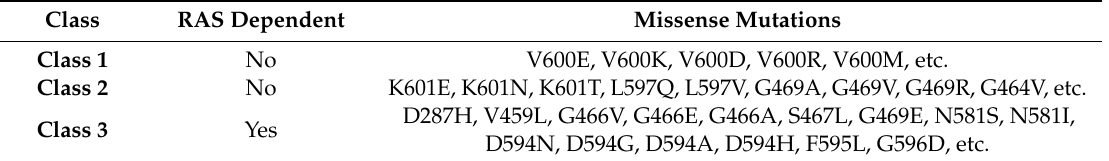
Figure 2. BRAF mutation spectrum in cancer. TCGA pan-cancer studies from cBioportal (https://www.cbioportal.org) were used for BRAF mutation lollipop plot. This plot summarizes 32 studies from TCGA that constitute 10,953 patients/10,967 samples. Somatic BRAF mutation frequency is 7.0% in these samples. The diagram shows the backbone of BRAF protein containing 766 amino acids (aa) with three main domains: (1) Raf-like RAS-binding domain (RBD, that spans 156–227 amino acids green), (2) phorbol esters/diacylglcerol-binding domain (C1 domain, 235–280aa, red), and (3) protein tyrosine kinase domain (Pkinase_Tyr, 458–712 aa, blue). The circles with different colors represent types of mutations: dark green, missense mutations; black, truncating mutations (including nonsense, nonstop, frameshift deletion, frameshift insertion, splice site mutations); dark red, in-frame deletion, in-frame insertion; pink, other mutations. Y -axis shows the frequency of particular BRAF mutations. Table 1. Catalog of prominent BRAF mutations in cancer.